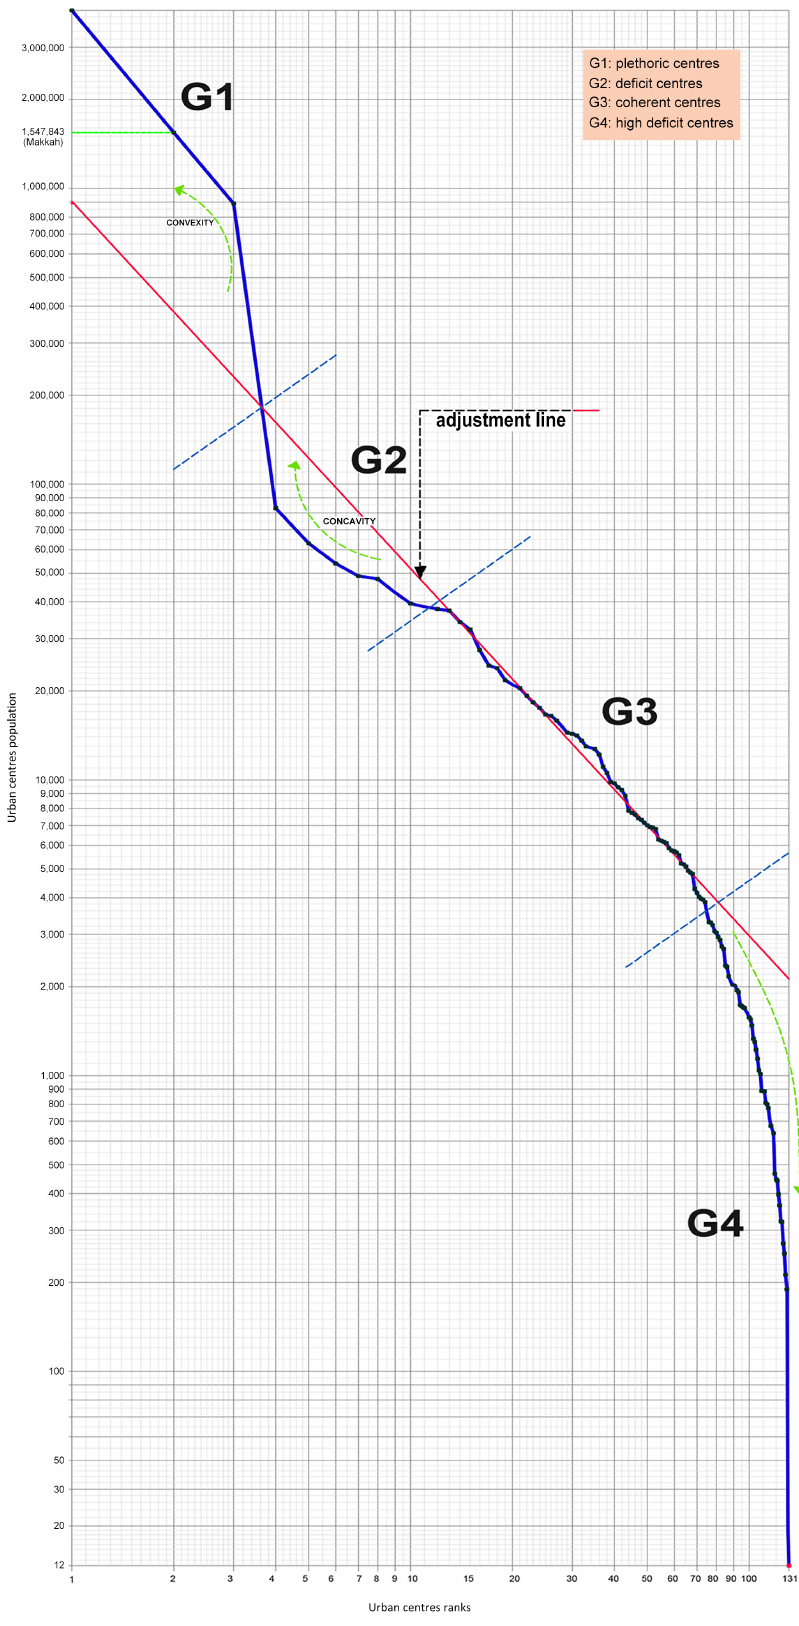
Fig. 10. Curve resulting from applying Zipf’s law for the Makkah